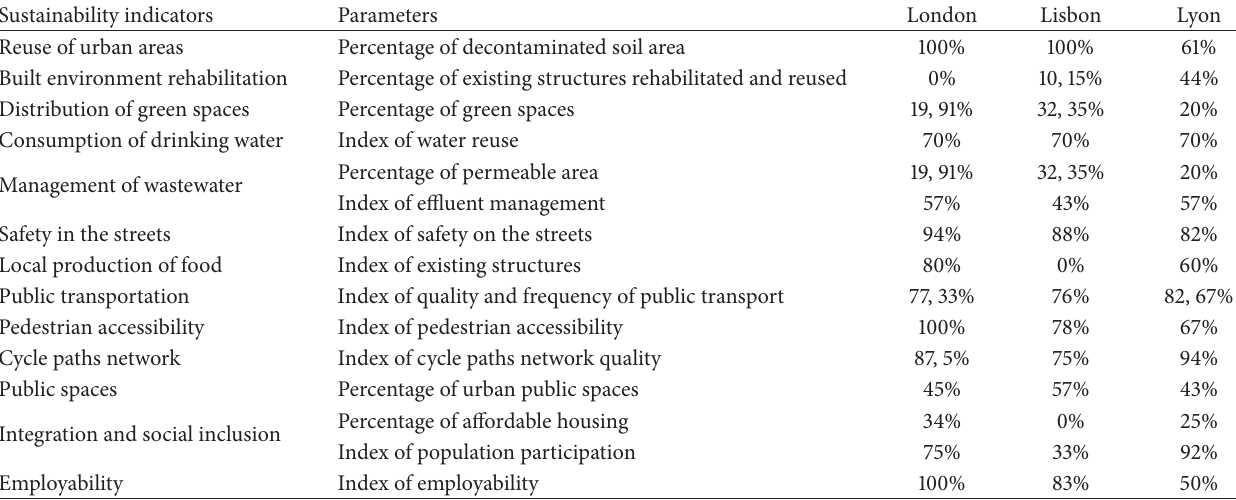
Table 3: Projects analysis—sustainability indicators scoring